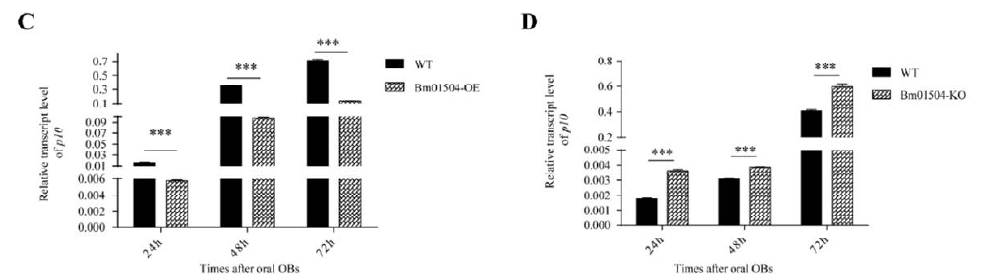
Figure 7. Anti- B. mori nucleopolyhedrovirus (BmNPV) activity of Bm01504-OE / Bm01504-KO.